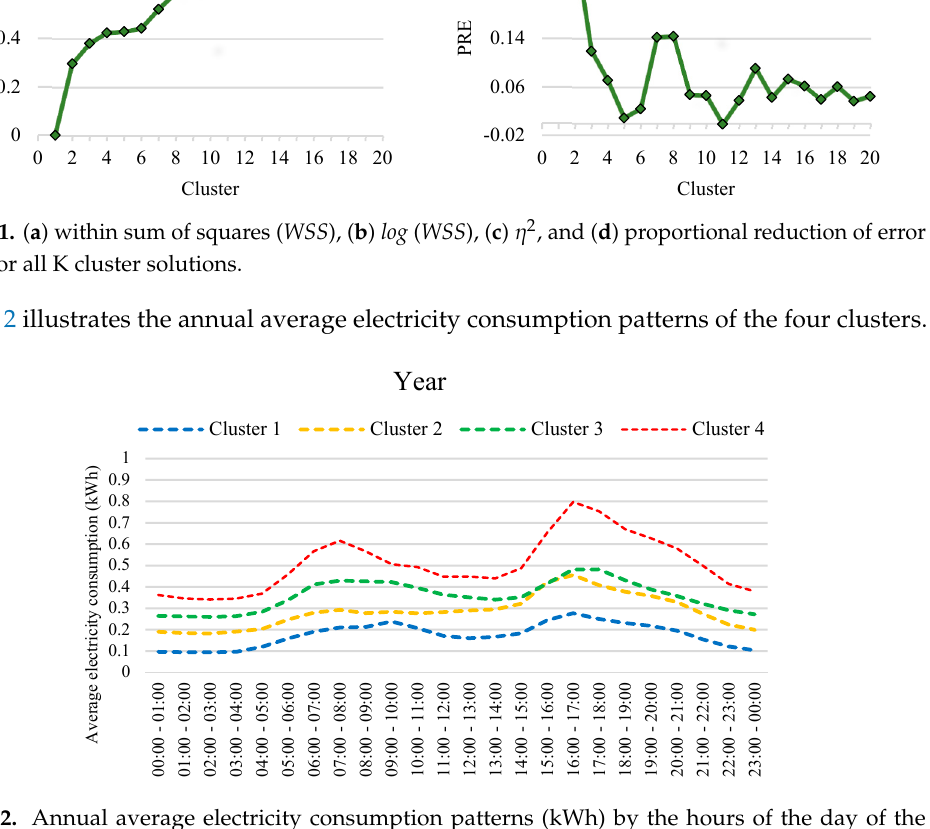
Figure 2. Annual average electricity consumption patterns (kWh) by the hours of the day of the four clusters.